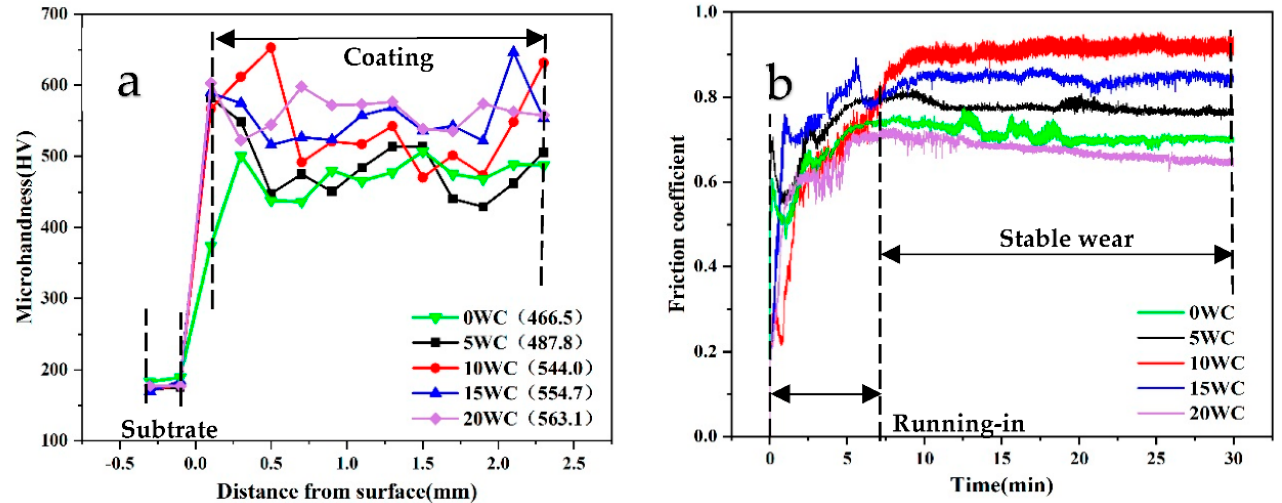
Figure 6. ( a ) Microhardness distribution in different coatings; ( b ) Friction coefficient of different coatings.